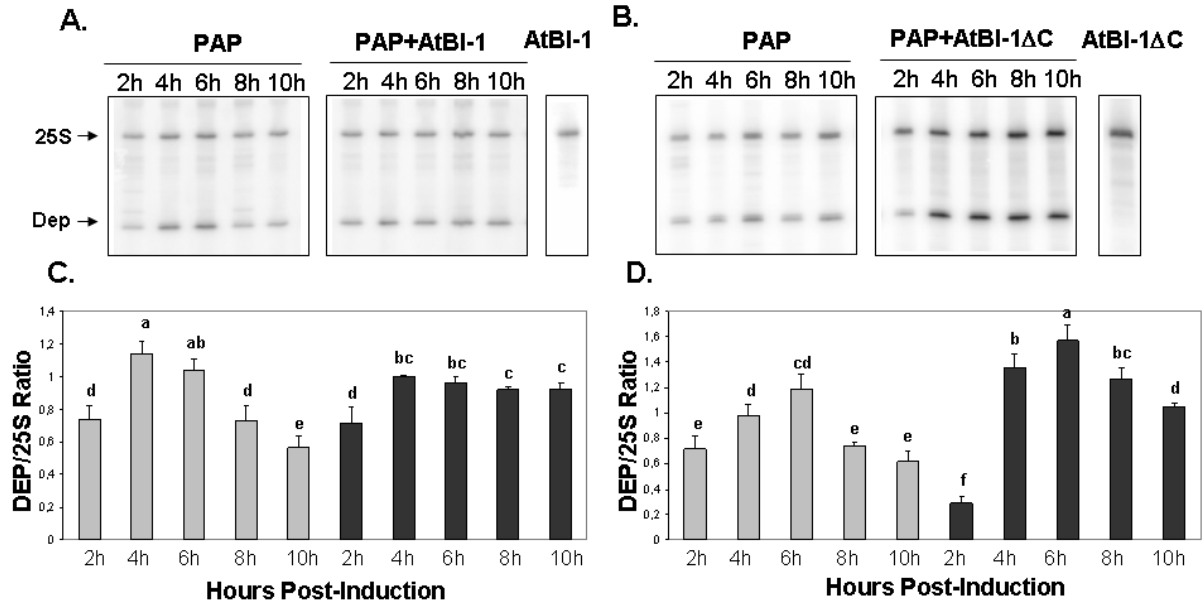
FIGURE 4 : Ribosome depurination in yeast cells. Primer extension analysis in yeast cells expressing PAP and AtBI-1 (A) or PAP and AtBI- 1ΔC (B) using two different end labeled primers, the depurination primer (Dep) was used to measure the extend of depurination and the 25S rRNA primer (25S) was used to measure the amount of 25S rRNA (C) and ratio of Dep/25S (D) . The results represent three independ- ent experiments. Columns are statistically different according to ANOVA (P < 0.001) followed by a post-hoc Fisher's Least Significant Dif- ference (LSD) test.